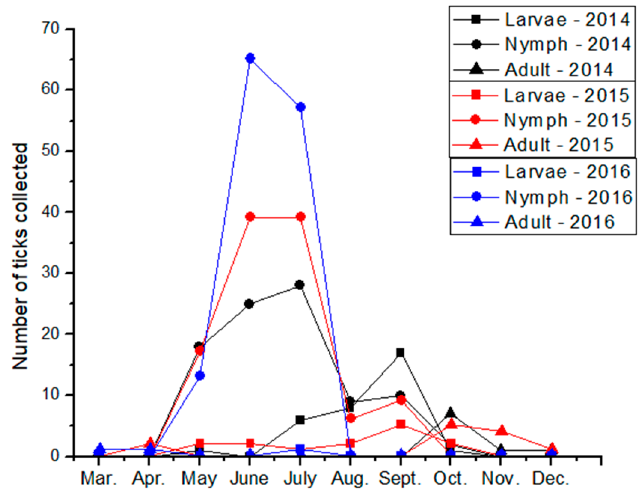
Figure 1. Monthly totals of Ixodes scapularis recoveries from the St. John collection, collected from one backyard site by passive surveillance every 2–3 days between 2014 and 2016.